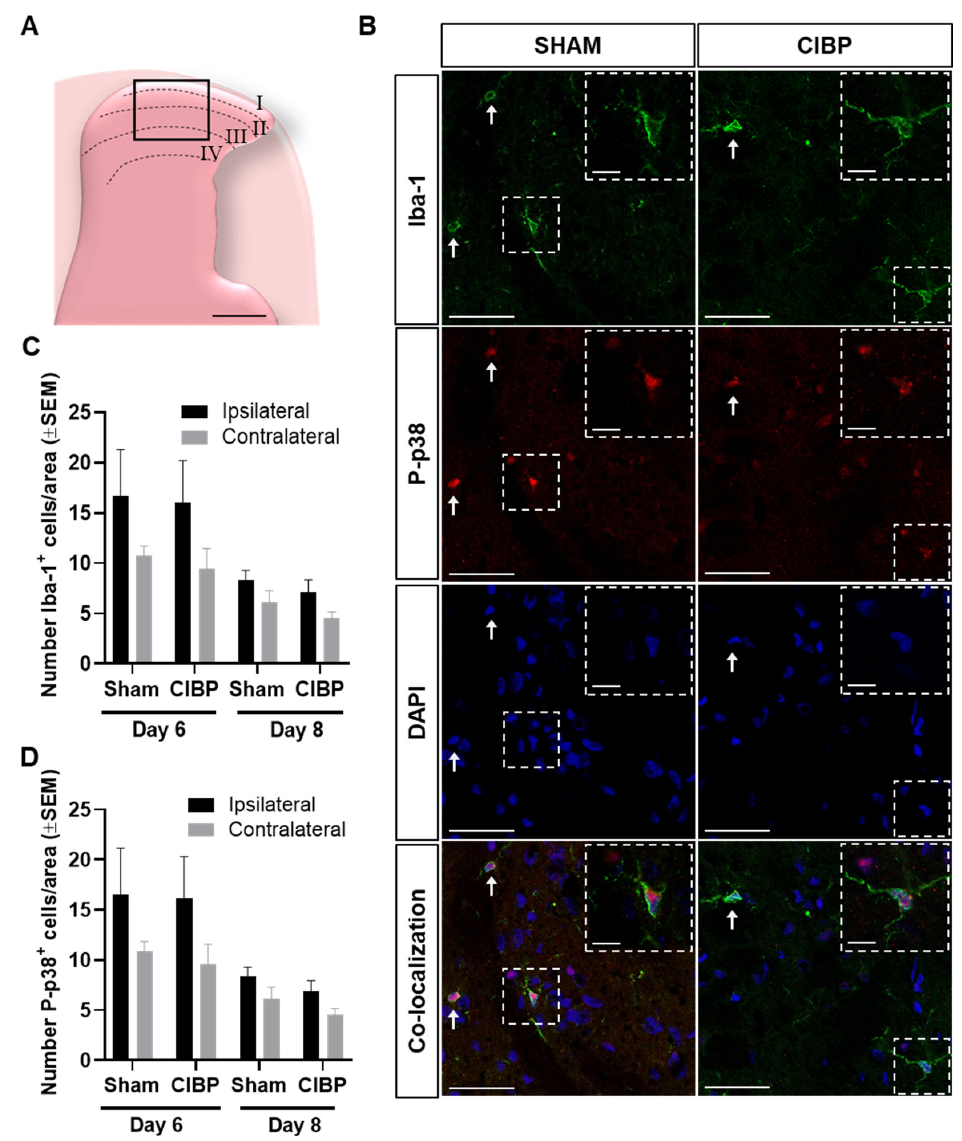
Figure2. ImmunohistochemicalcharacterizationofmicroglialreactioninthefemaleWalker256modelof Figure 2. Immunohistochemical characterization of microglial reaction in the female Walker 256 CIBP.( A )Diagramdemonstratingtheareaofthespinalcorddorsalhornusedforanalysis(347 × 260 µ m 2 ). model of CIBP. ( A ) Diagram demonstrating the area of the spinal cord dorsal horn used for analysis Scale bar indicates 250 µ m. ( B ) Representative confocal images of microglia characterization (Iba-1, (347 × 260 µm 2 ). Scale bar indicates 250 µm. ( B ) Representative confocal images of microglia P-p38, DAPI, and co-localization) in the lumbar spinal cord of sham and cancer-bearing rats. Arrows characterization (Iba-1, P-p38, DAPI, and co-localization) in the lumbar spinal cord of sham and indicate Iba-1 + , P-p38 + , and DAPI + cells. Arrows indicate examples of microglia cells expressing Iba-1 + , cancer-bearing rats. Arrows indicate Iba-1 + , P-p38 + , and DAPI + cells. Arrows indicate examples of P-p38, and DAPI + . Images were obtained with a 40 × objective lens, scale bars indicate 50 µ m, and scale microglia cells expressing Iba-1 + , P-p38, and DAPI + . Images were obtained with a 40× objective lens, bars in the inserts indicate 10 µ m. ( C ) The number of Iba-1 + cells was not significantly higher in the scale bars indicate 50 µm, and scale bars in the inserts indicate 10 µm. ( C ) The number of Iba-1 + cells ipsilateral dorsal horn of the spinal cord of cancer-bearing rats, compared with the contralateral side was not significantly higher in the ipsilateral dorsal horn of the spinal cord of cancer-bearing rats, and with sham rats on post-surgical days 6 or 8. ( D ) The number of P-p38 + cells did not significantly compared with the contralateral side and with sham rats on post-surgical days 6 or 8. ( D ) The number di ff er between the ipsilateral and contralateral dorsal horns, nor between the ipsilateral dorsal horns of of P-p38 + cells did not significantly differ between the ipsilateral and contralateral dorsal horns, nor cancer-bearing and sham rats on post-surgical days 6 or 8. For each time point: Sham n = 5, CIBP n = 6. Data are presented as mean ±